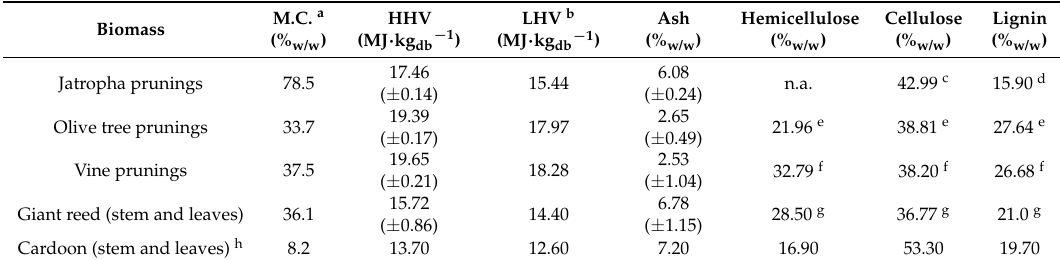
Table 2. Physical characteristics of jatropha wood in comparison with other types of biomass (figures in parentheses are standard